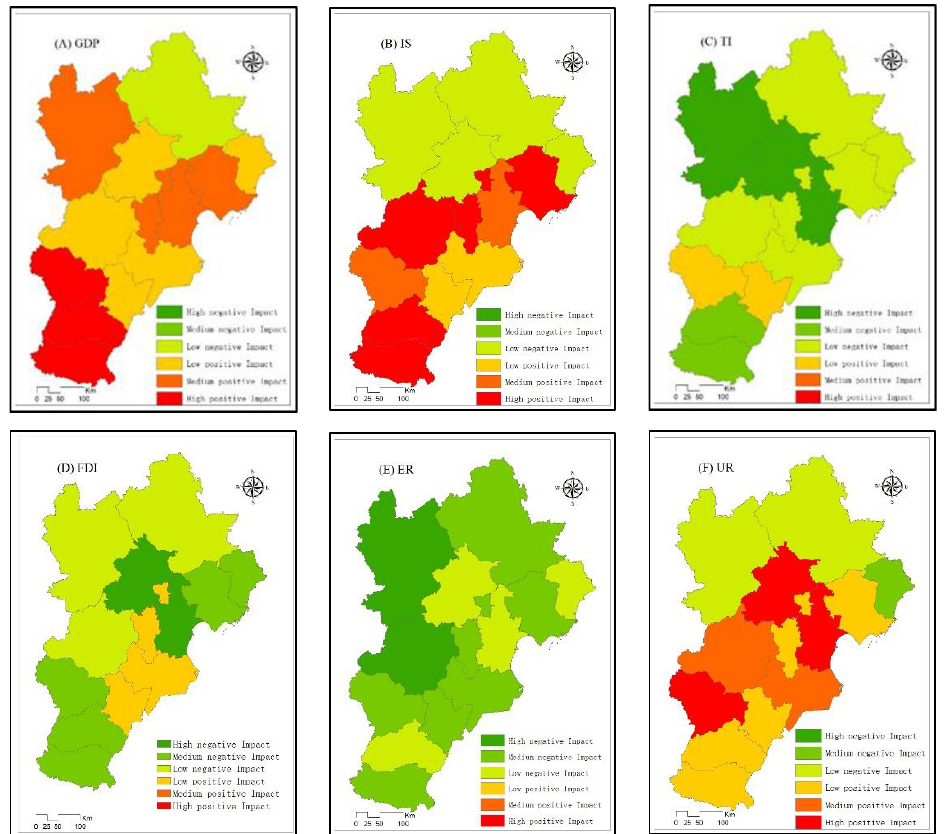
Figure 5. Spatial distribution of regression coefficients for socioeconomic factors in the Beijing – Tian- jin – Hebei urban agglomeration during the study period.